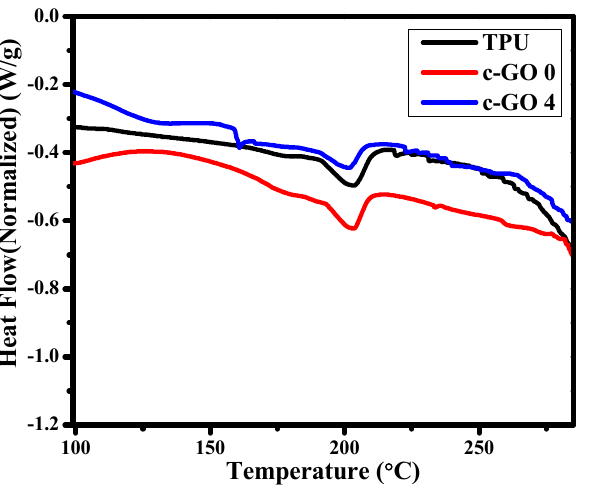
Figure 6. DSC thermogram of pristine TPU and TPU based composite membranes (c-GO 0 and c-GO4).